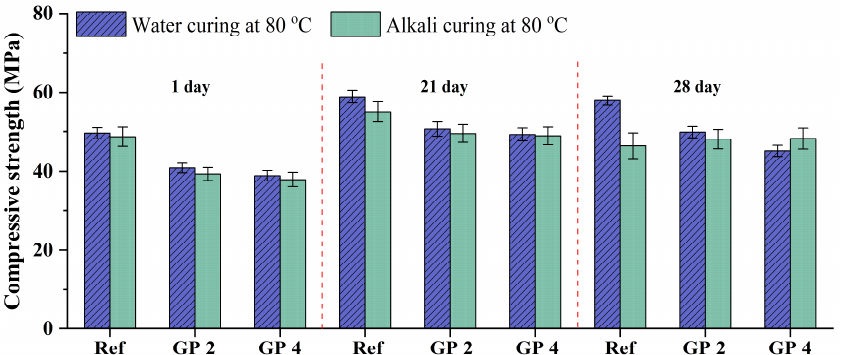
Figure 12. Compressive strengths of GA mortars under alkali curing at 80 °C and water curing at 80 °C.